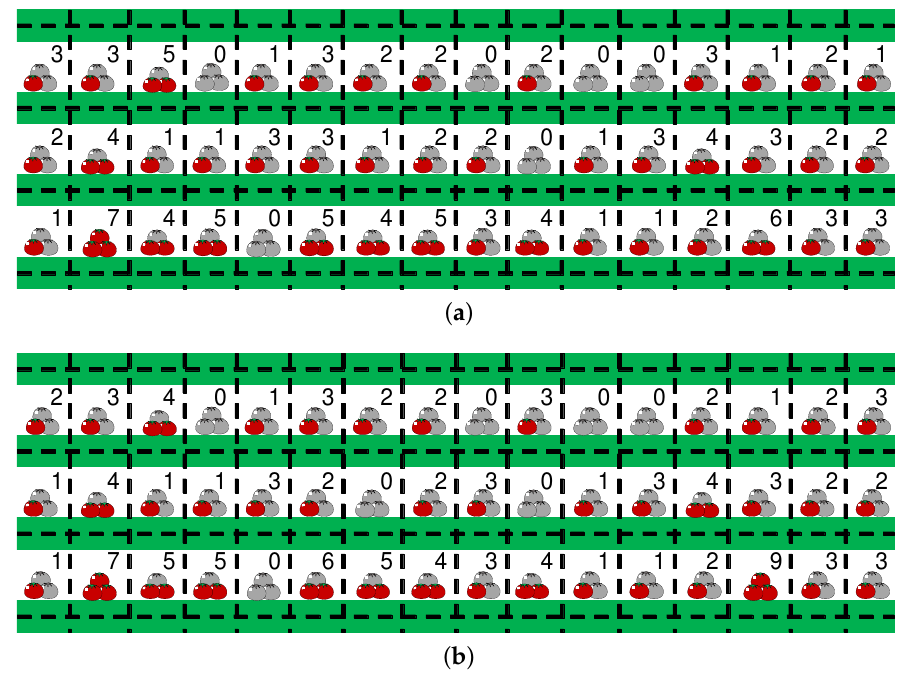
Figure 10. Harvesting maps generated using recognition results ( a ) and ground truth ( b ). As depicted in Figure 2, the green lines in bold line denote ridges and the black dotted lines denote the boundary lines of sections. The number of harvested tomatoes within each section was visualized with a pictogram and real